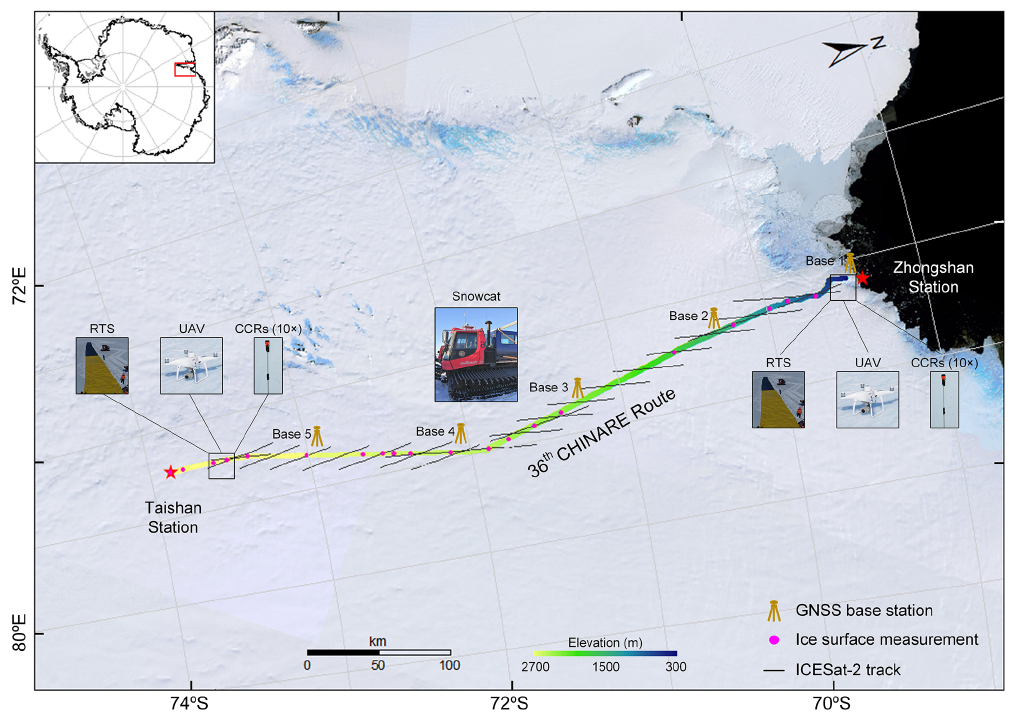
Figure 1. ICESat-2 validation campaign based on coordinated multi-sensor ground observations along the 36th CHINARE route. The Landsat image mosaic of Antarctica (Bindschadler et al., 2008) is used as